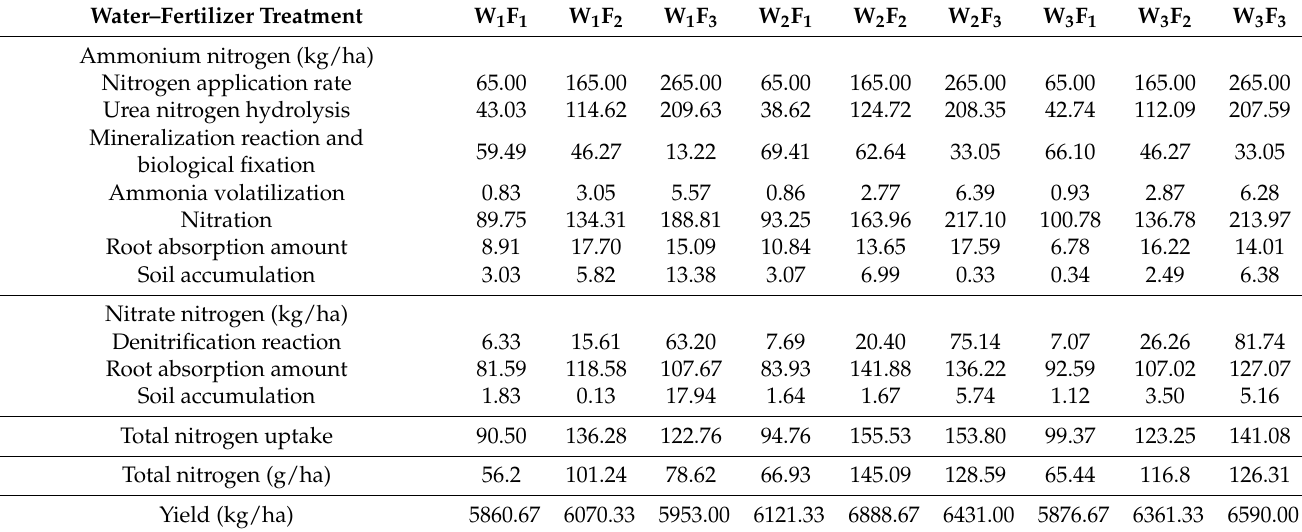
Table 7. HYDRUS-2D case predictions of nitrogen balance and measured yield.